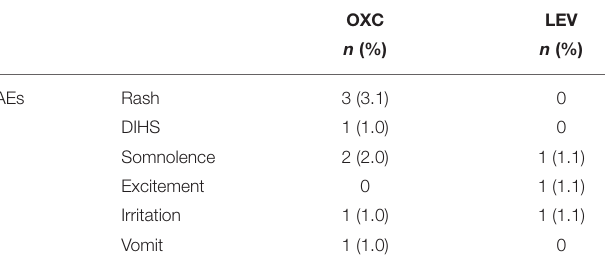
TABLE 3 | Reported adverse events (AEs) ( n =